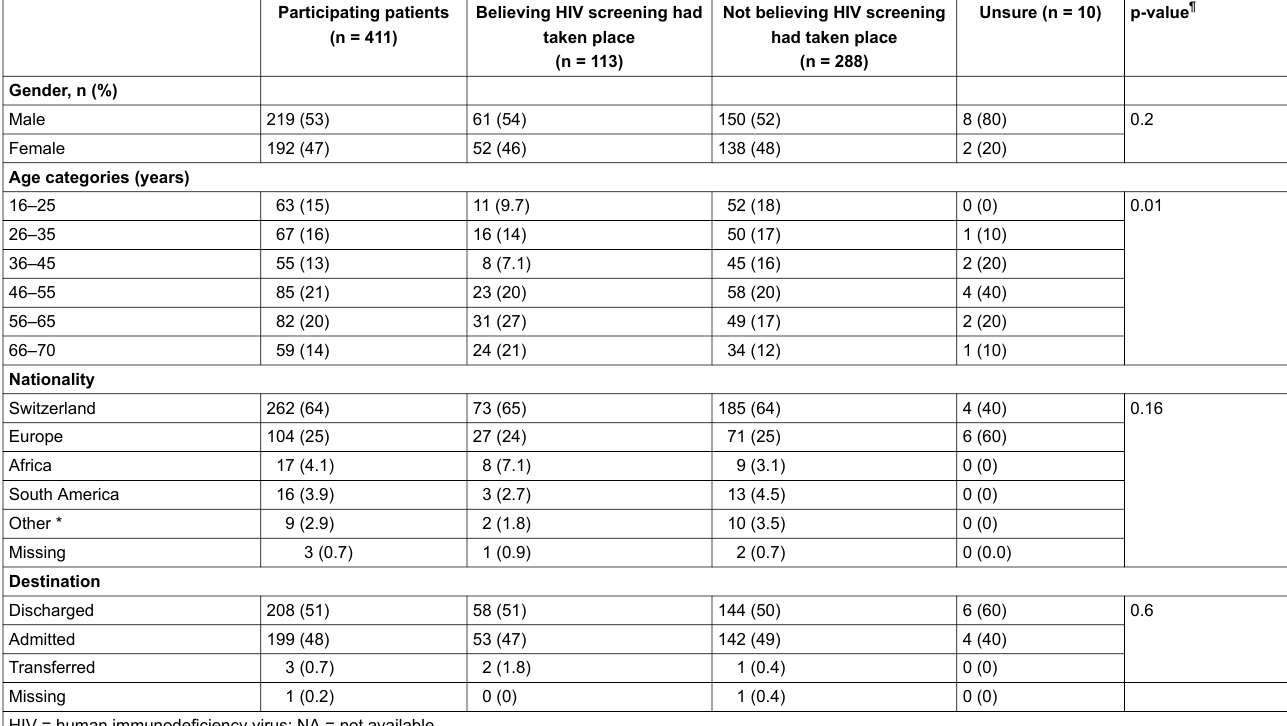
Table 1: Demographic parameters of the 411 participating patients, those believing they had been screened for HIV as part of their emergency department work-up, those not believing they had been screened for HIV and those unsure. Participating patients (n =